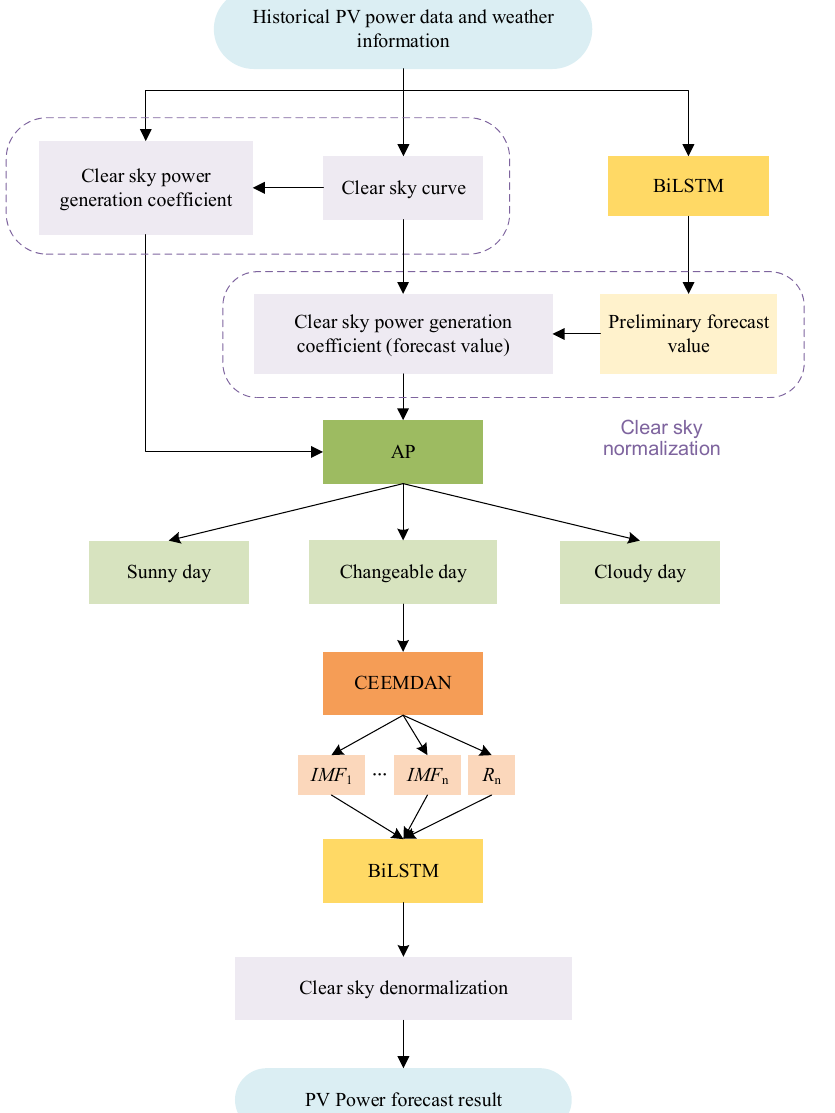
Figure 3. The ultra-short-term PV power forecasting framework based on weather type clustering. 1.